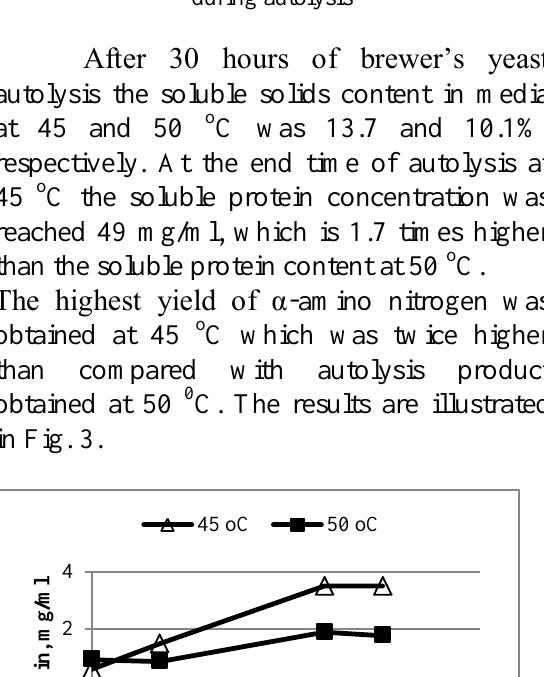
Fig. 5. The soluble protein concentration of yeast hydrolysate